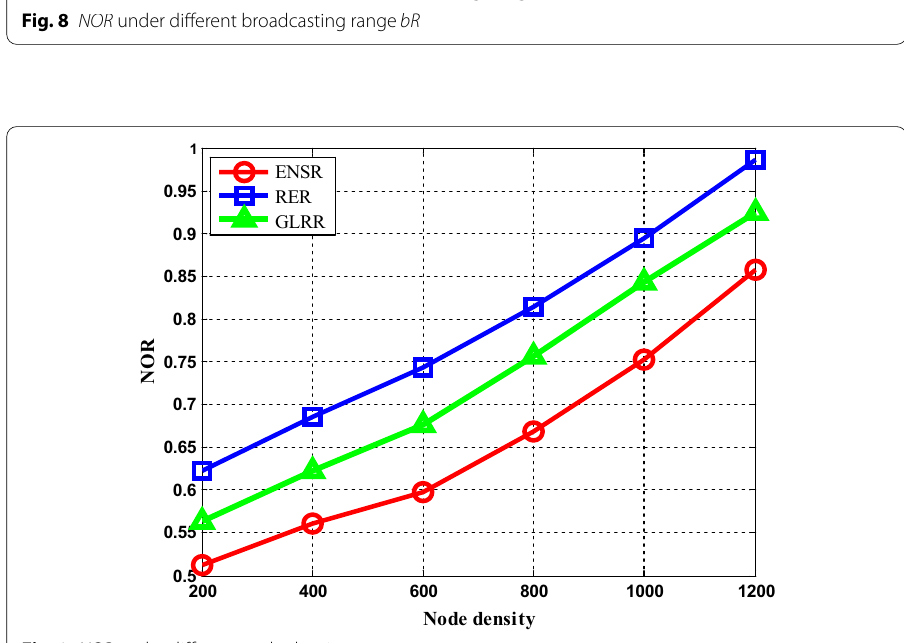
Fig. 9 NOR under different node